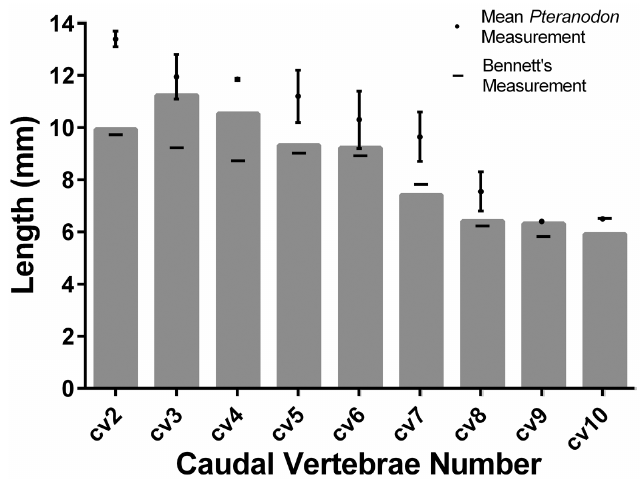
Figure 6: Caudal vertebrae lengths, comparing our measure- ments (in grey) of UALVP 24238 with those of Benett (2001a), as well as the mean and range of vertebral lengths reported for other Pteranodon sensu lato (Bennett 2001a) based on AMNH 6158, UALVP 24238, YPM 2489, YPM 2462, and YPM